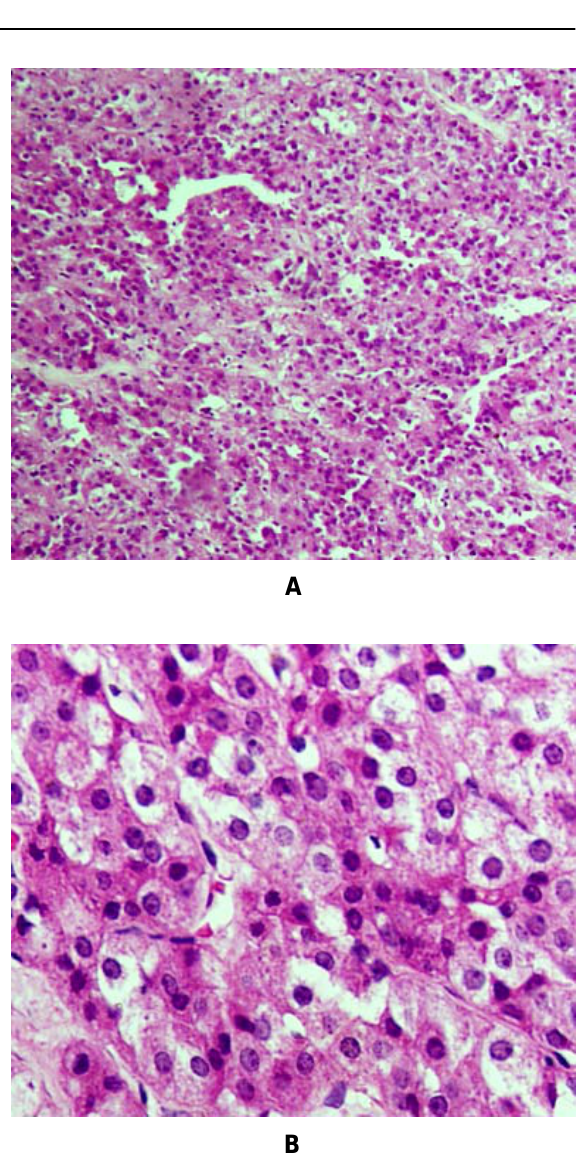
Figure 2. Histology of the right ovary, A - in low power field and B - in high power field show clusters of round cuboidal cells with mildly pleomorpic central vesicular nuclei with single prominent